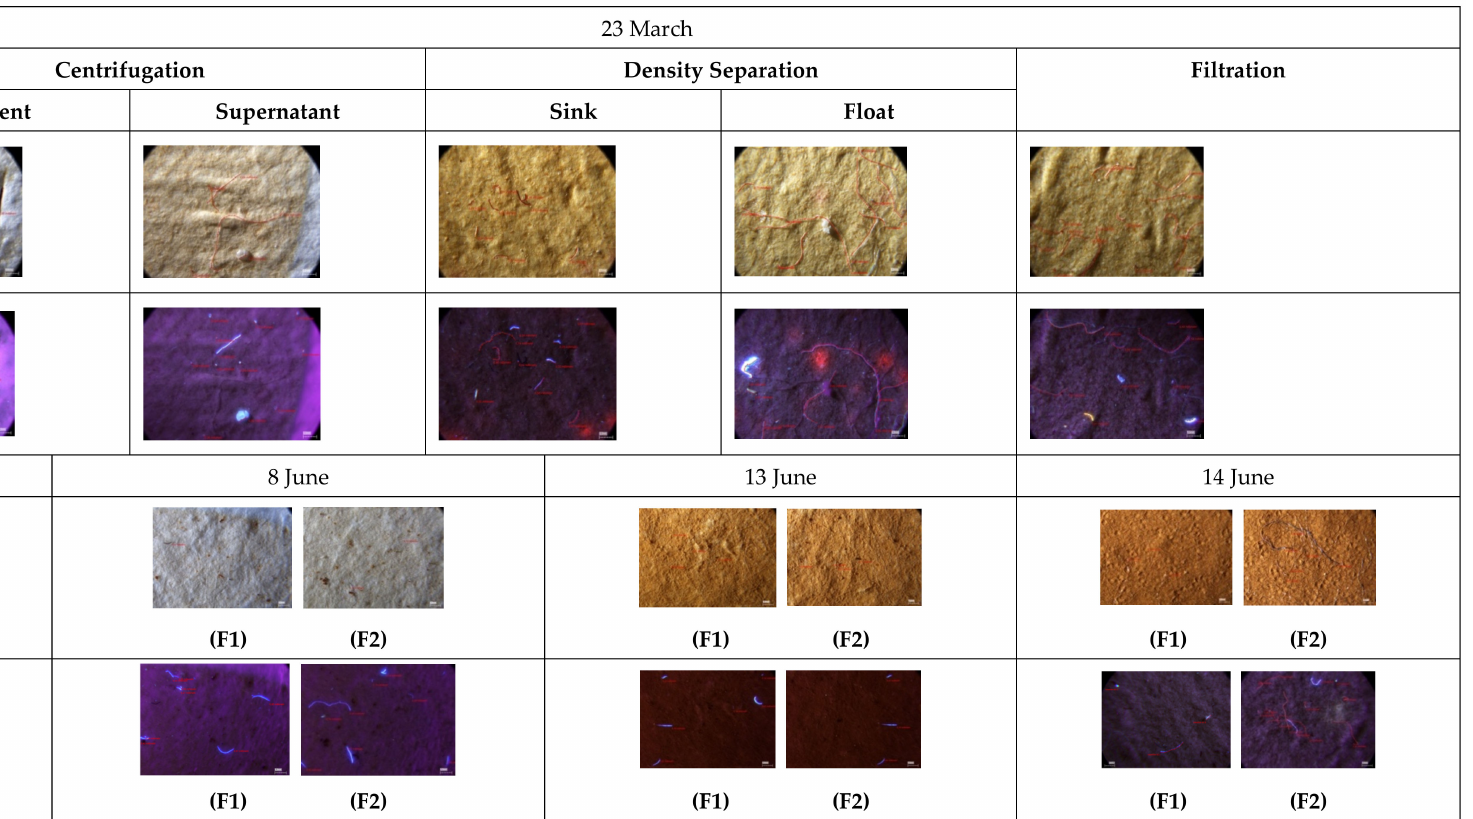
Figure 1. Microscopic images (normal and UV light) of the filters deriving from the inflow